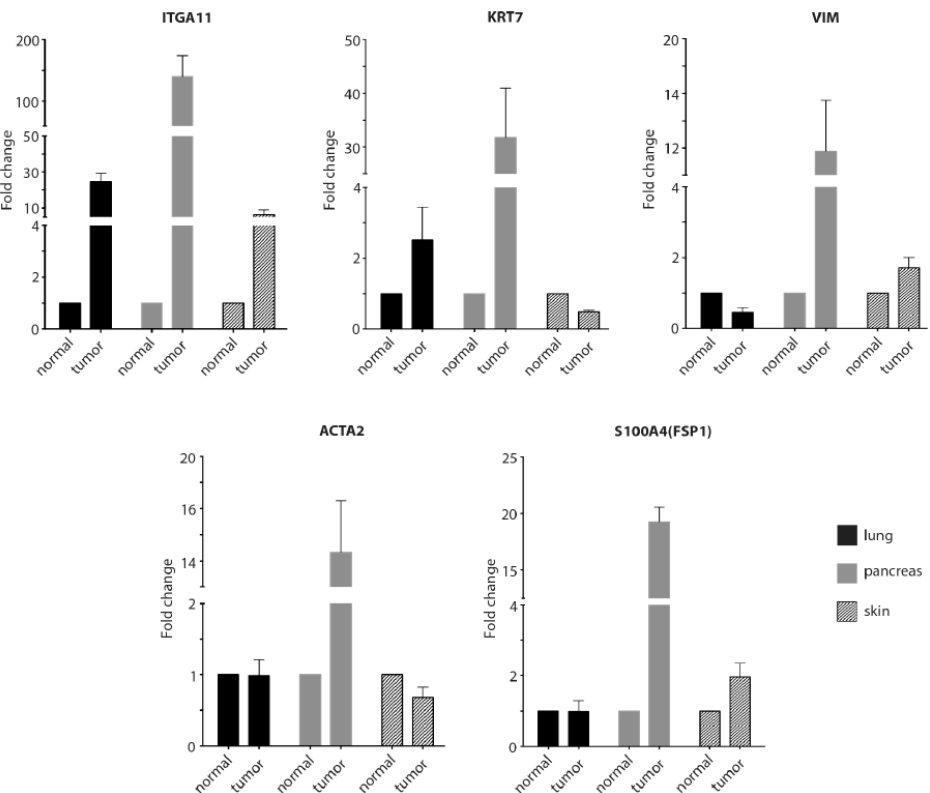
Figure 4. Comparison of mRNA expression of integrin α 11 and various markers in selected normal and tumor tissues. Total RNA was extracted from the normal and tumorous lung, pancreas and skin tissues on which immunostaining had previously been performed. mRNA levels of integrin α 11 (ITGA11), cytokeratin 7 (KRT7), vimentin (VIM), alpha smooth muscle actin ( α SMA) (ACTA2), and fibroblast-specific protein 1 (FSP1) (S100A4) were analyzed by RT-qPCR. Glyceraldehyde-3-phosphate dehydrogenase (GAPDH) was amplified as a reference gene for normalization. Each gene expression level is presented as a fold change in tumor tissue relative to the normal tissue. Shown is the average fold change of the mRNA extracted from each sample, but reverse transcribed and amplified in three independent experiments. Error bar indicates the standard deviation from the average.